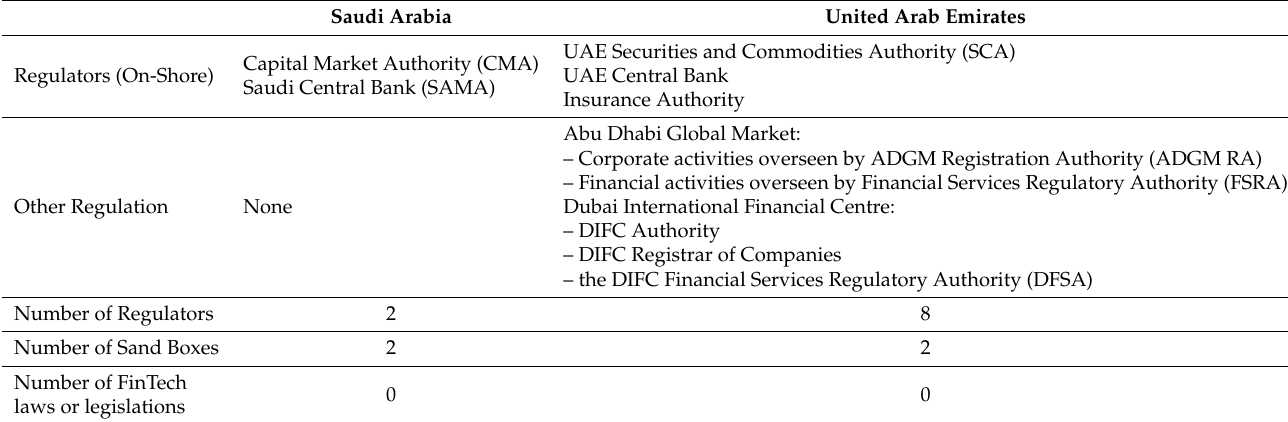
Table 4. A comparison of the regulation environments in Saudi Arabia and the United Arab